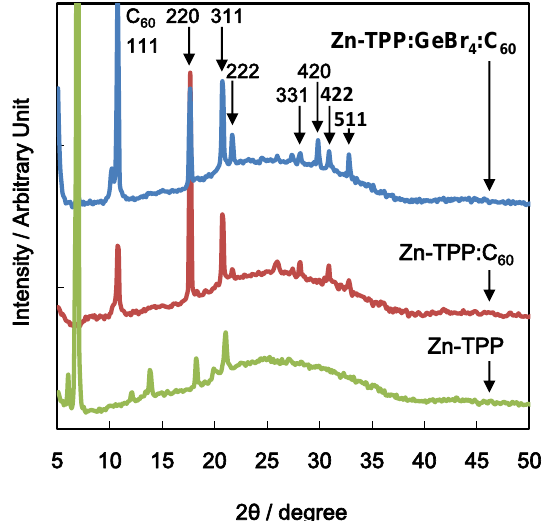
Figure 3. X-ray diffraction patterns of the bulk heterojunction thin films.